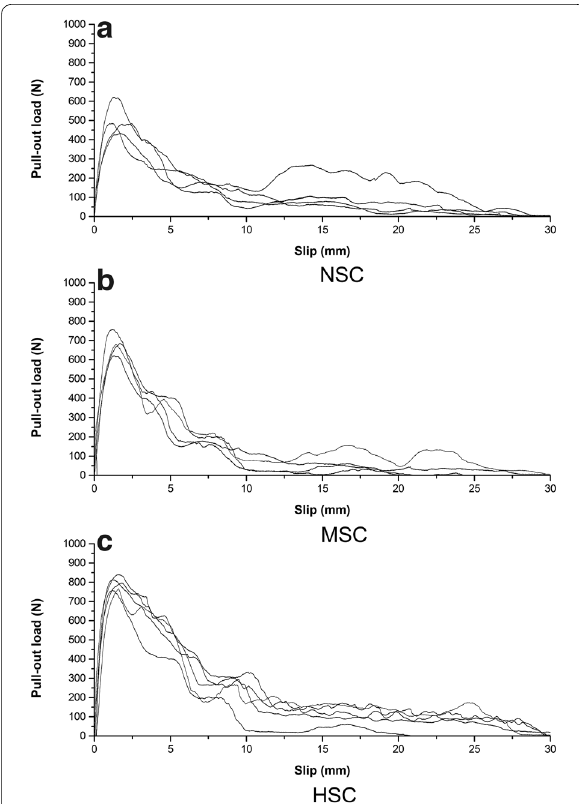
Fig. 7 Pull-out-slip curves of 4DH hooked-end steel fibres. a NSC, b MSC and c HSC